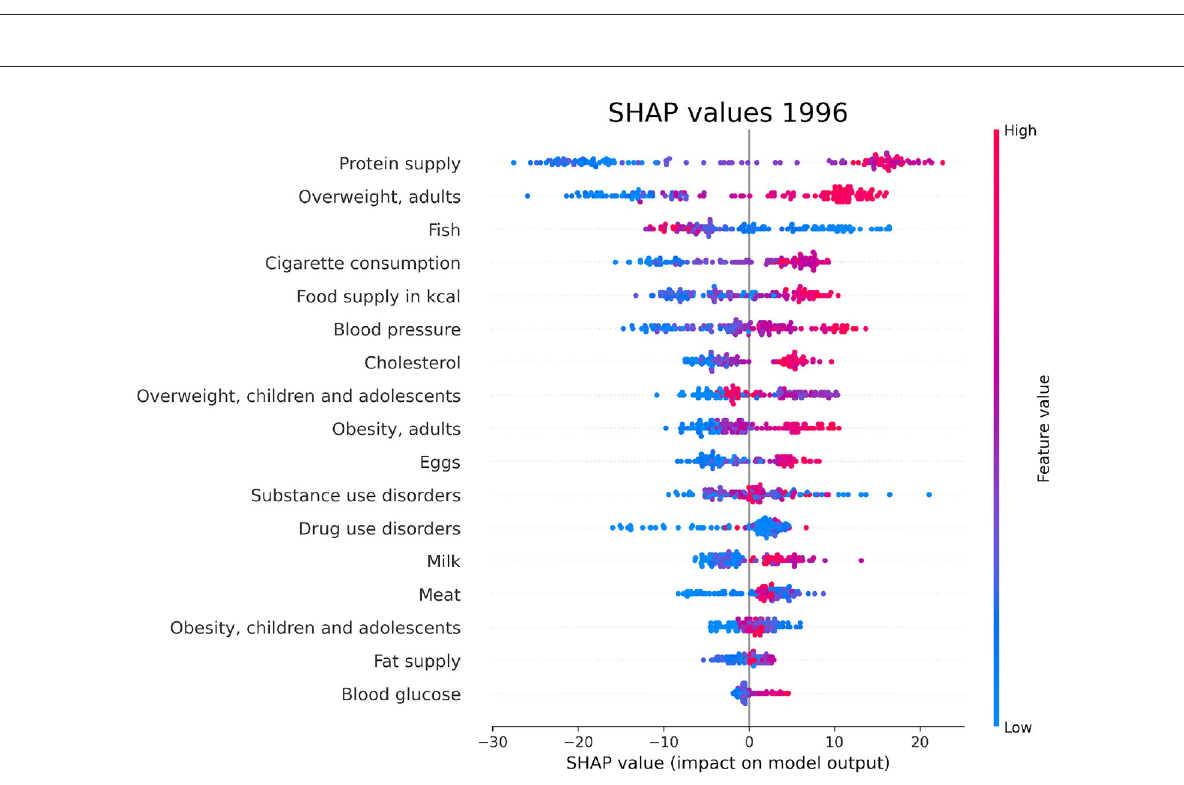
FIGURE6 SHAP values corresponding to the features that are most influential in the prediction of PAD for the year 1996. Different points in the same row are associated to the prediction made for different